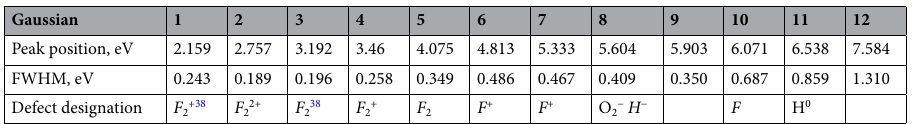
Table 1. Peak positions and bandwidths of elementary Gaussians and their connection with specific neutron- induced defects (if possible) in α-Al 2 O 3 crystals. The assignment of absorption bands to the F -and F 2 -type centers is based on literature data 24,25,28–32,37,38 , while oxygen-interstitial-related bands are considered for the first time in the present study ( H 0 ) and for H − —in our recent publication 42 (see text for details).